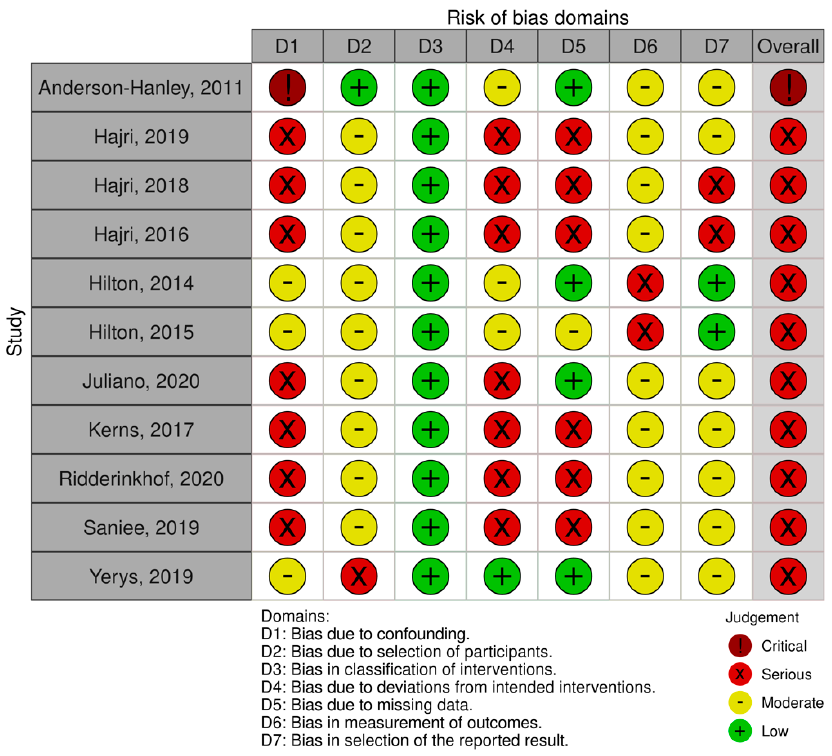
Figure 3. Percentages of risk bias in randomized control trials (RCTs, green: low bias risk; yellow: some concerns; red: high bias risk).